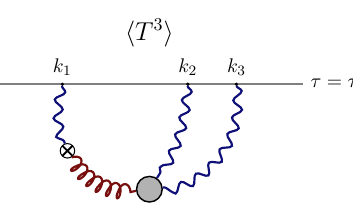
Figure 7 . The simplest bulk mixing diagram in which a PM field contributes to